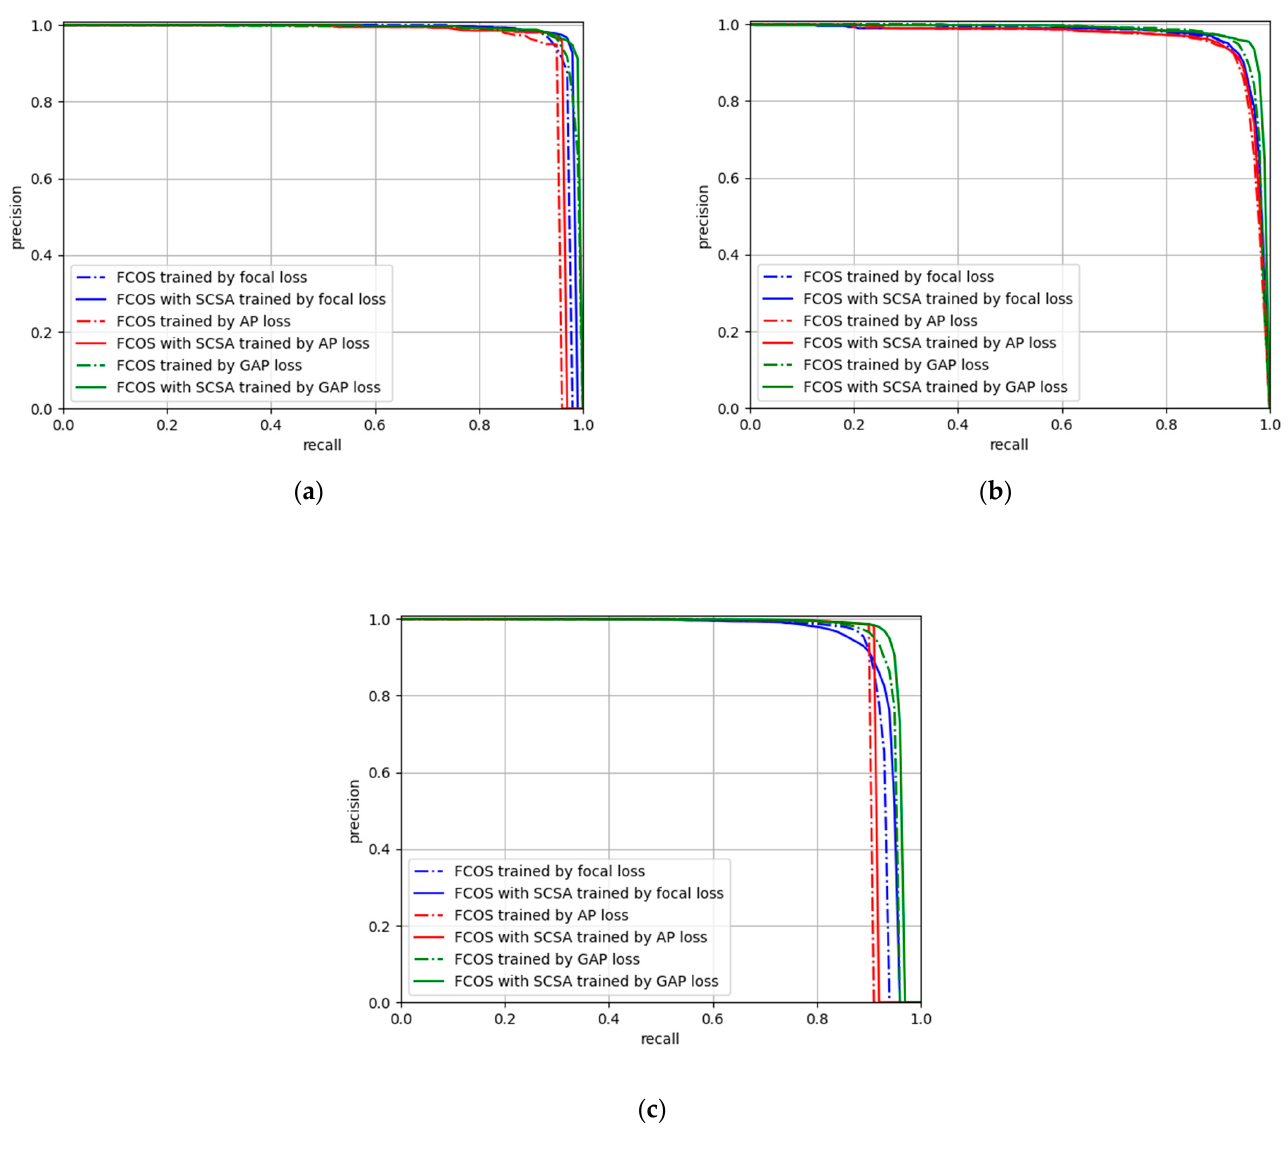
Figure 7. Precision-Recall curves (PR curves) of SCSA-Net with different settings. ( a ) PR curves of SCSA-Net with different settings on SSDD. ( b ) PR curves of SCSA-Net with different settings on SAR-Ship-Dataset. ( c ) PR curves of SCSA-Net with different settings on HRSID.